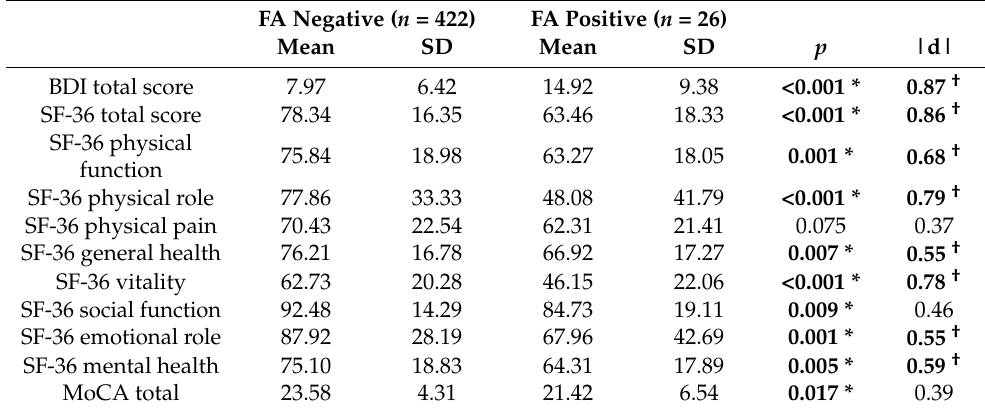
Table 3. Comparison of psychological measures.